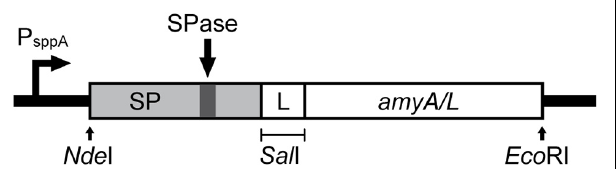
FIGURE 1 | Schematic overview of the expression cassette for the secretory production of α -amylases. The non-native signal peptides (SP) were translationally fused to the amyA or amyL with the linker GTCGAC, which is a Sal I site, located after 2 codons downstream of the signal peptide cleavage site. This expression cassette was inserted in the pSIP401